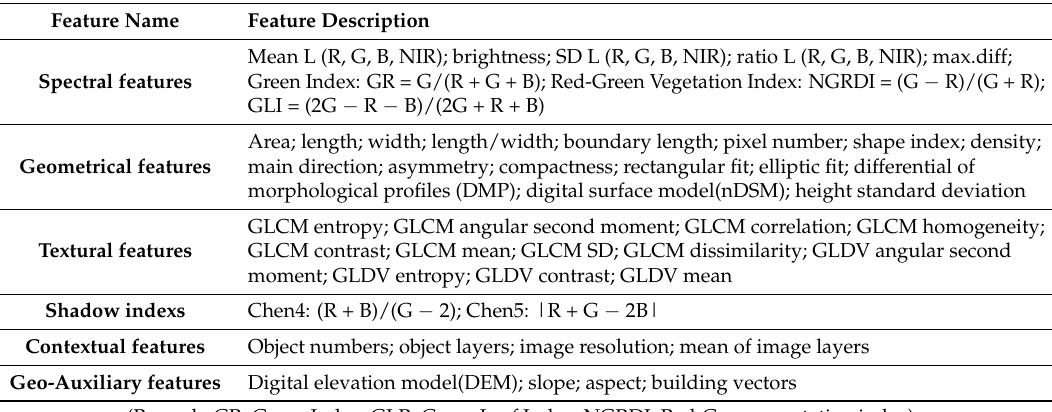
Table 2. Description of features extracted from unmanned aerial vehicle